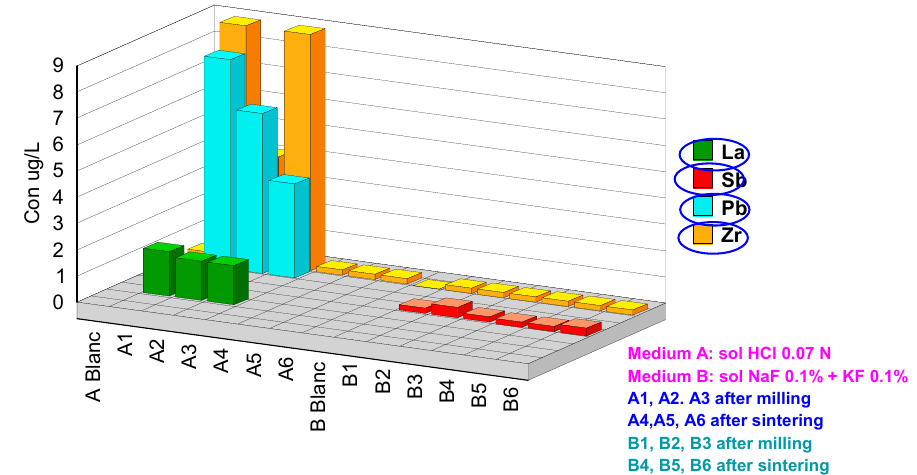
Figure 6. Cations released in the μ g/L scale.